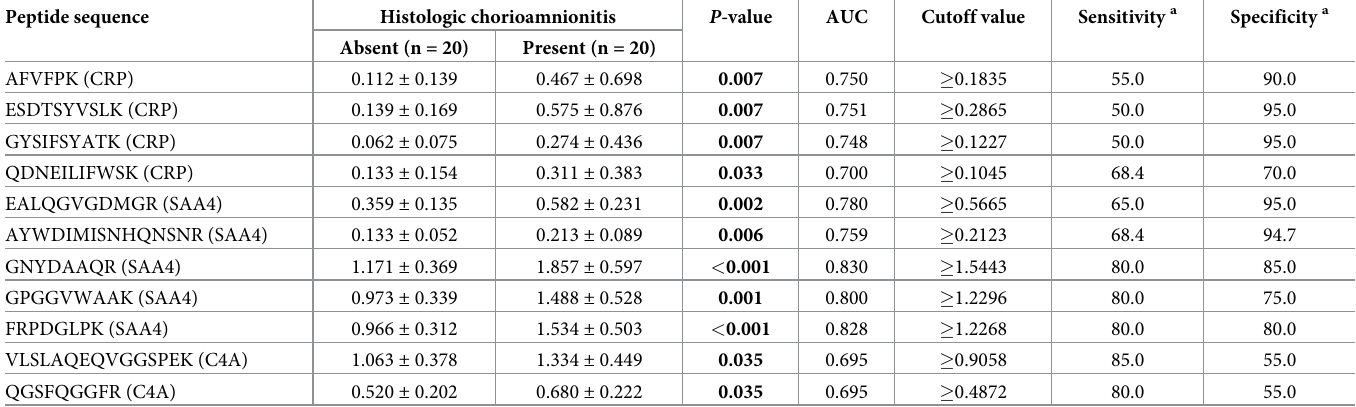
AUC, areas under the curves; CRP, C-reactive protein; SAA4; serum amyloid A4; C4A, complement C4-A. Data are given as the means ± standard deviation (peak area ratio). a Values are given as %.